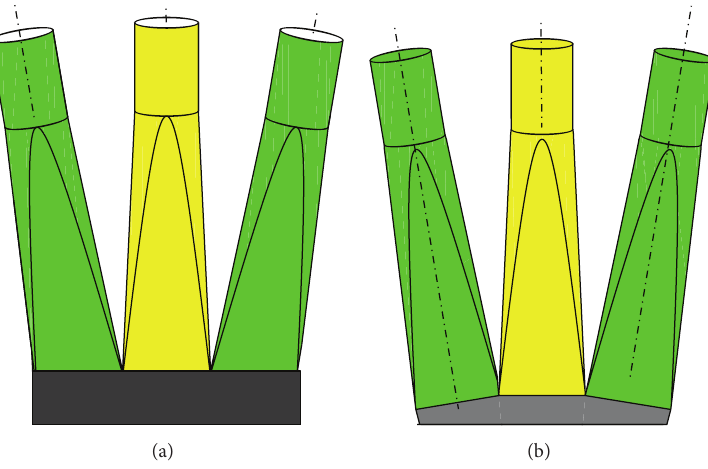
Figure 3: CTPCs cross section: (a) flat design and (b) carved design.